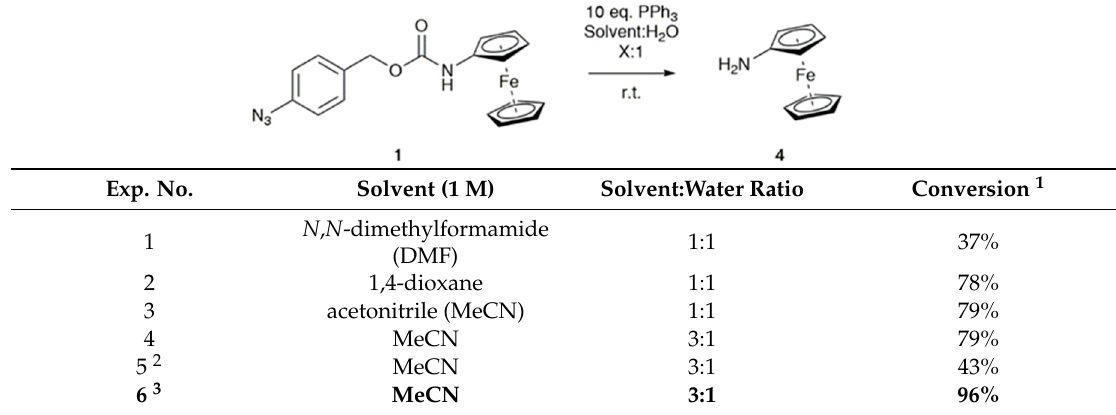
Table 1. Optimization of the reaction assay of 1 (1 mM) with triphenylphosphine (10 mM).